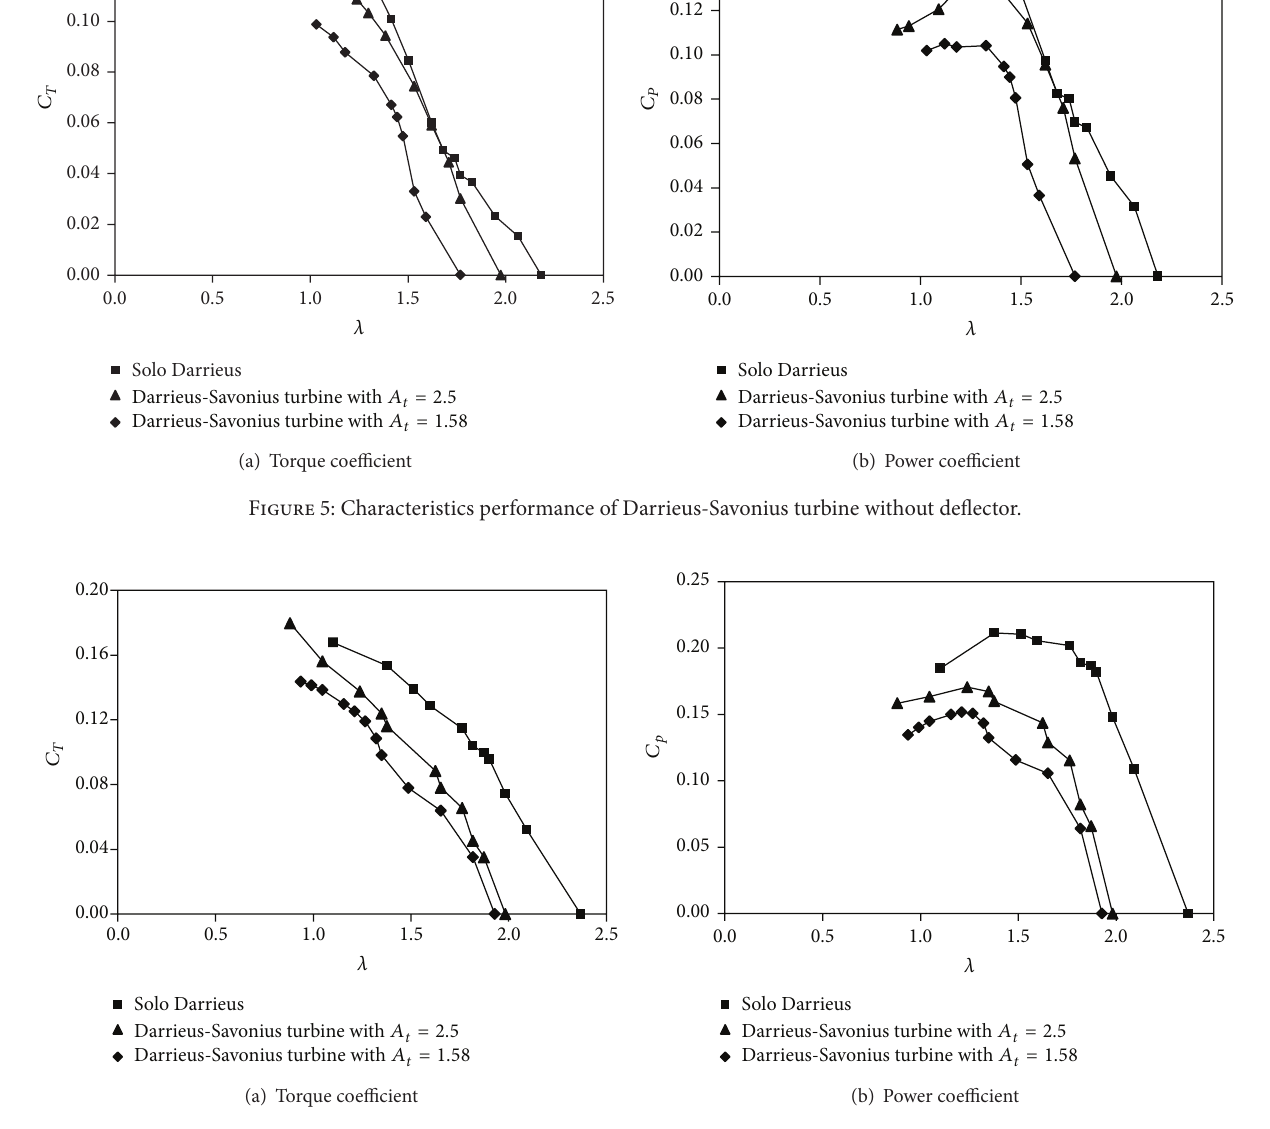
Figure 6: Characteristic performance of Darrieus-Savonius turbine with